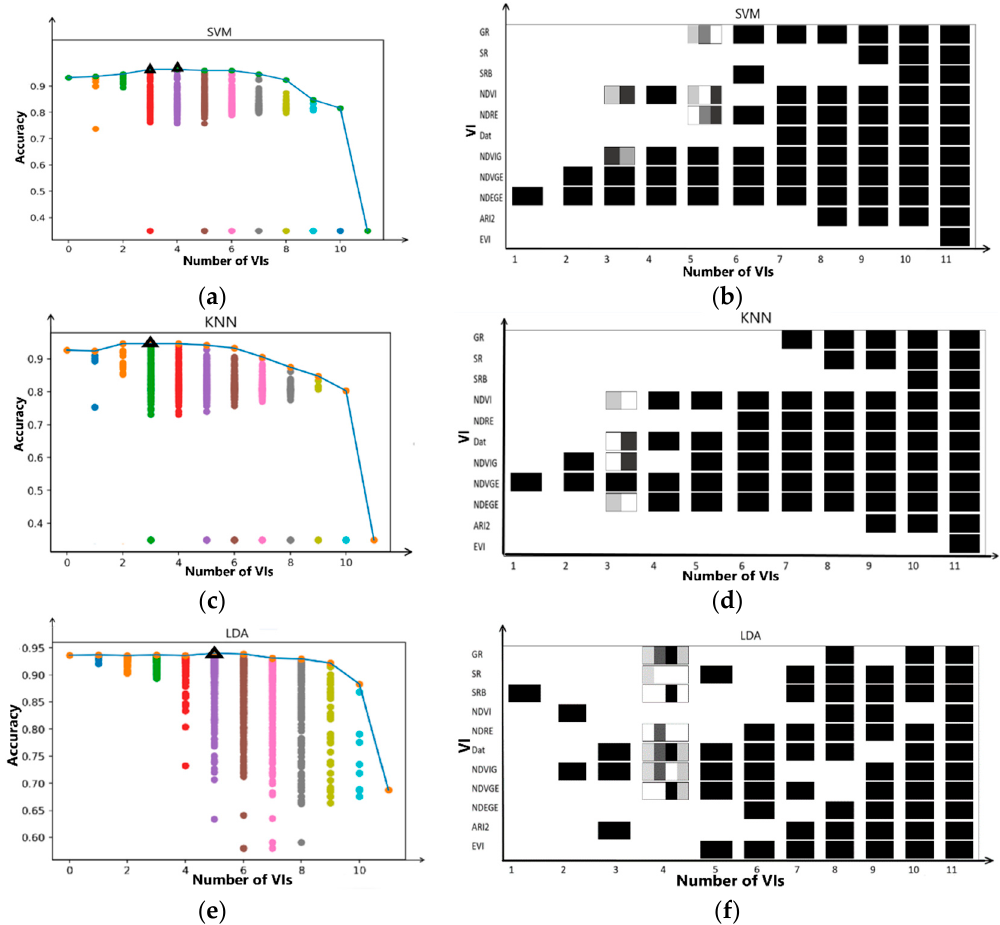
Figure 8. ( a , c , e ): The scatter points shows the distribution for the accuracy of different combinations. The curve consists of the highest precision under the same number of vegetation indices, and the black triangle indicates the highest point of the curve. ( b , d , f ): Show the distribution of vegetation indices under the best recognition accuracy. Squares of different gray levels are used to represent multiple combinations of different vegetation indices at the best accuracy, for example, 3 VIs in SVM of ( b ), black means this VI is shared by all combinations, white means not in any combination, light grey and dark grey mean this VI is in one variety to achieve the same best performance.